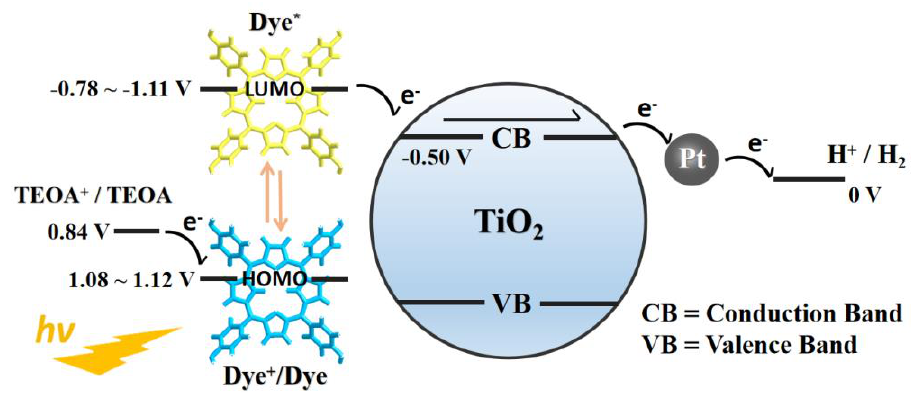
Figure 5. Proposed mechanism of photocatalytic H 2 production over Pt/porphyrin-TiO 2 .